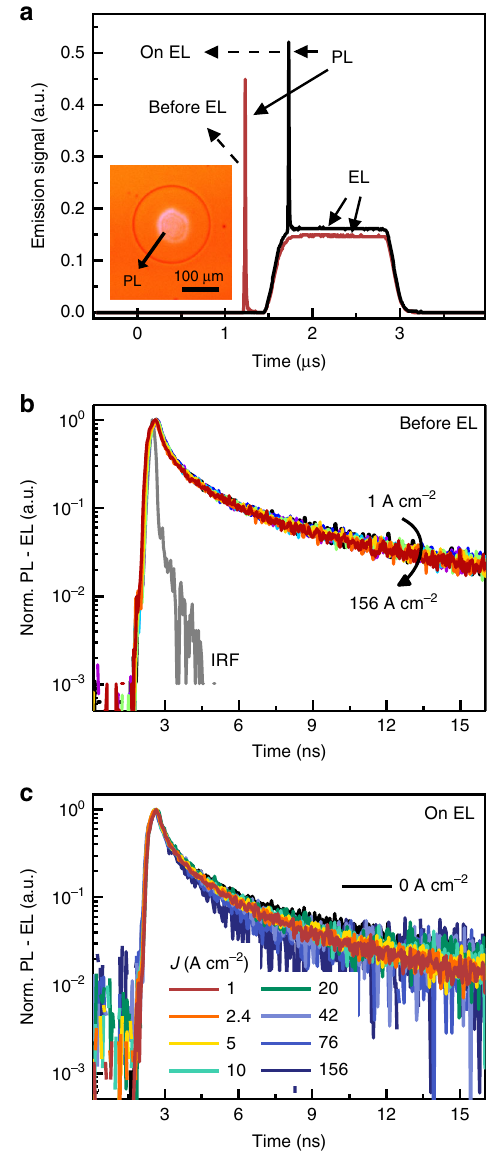
Fig. 8 Relevance of Auger quenching. a Aggregate emission signal resulting from a 20 ps optical excitation pulse ( λ = 355 nm, 10.7 µ J cm − 2 fl uence) incident on an LED just before (red line) and just after the start of a 1.5 µ s, 45 A cm − 2 electroluminescence pulse. The inset shows the overlap of the optical pump spot with the device area. The photoluminescence decay remains unchanged as a function of current density in both the before ( b ) and after ( c ) timing con fi gurations up to the limit of 156 A cm − 2 reached in this experiment. Note that the faster overall decay of the photoluminescence transients here as compared to Fig. 3 results from the higher pump fl uence used in this case. The instrument response function (IRF) is shown by the gray line with a temporal resolution of 0.2